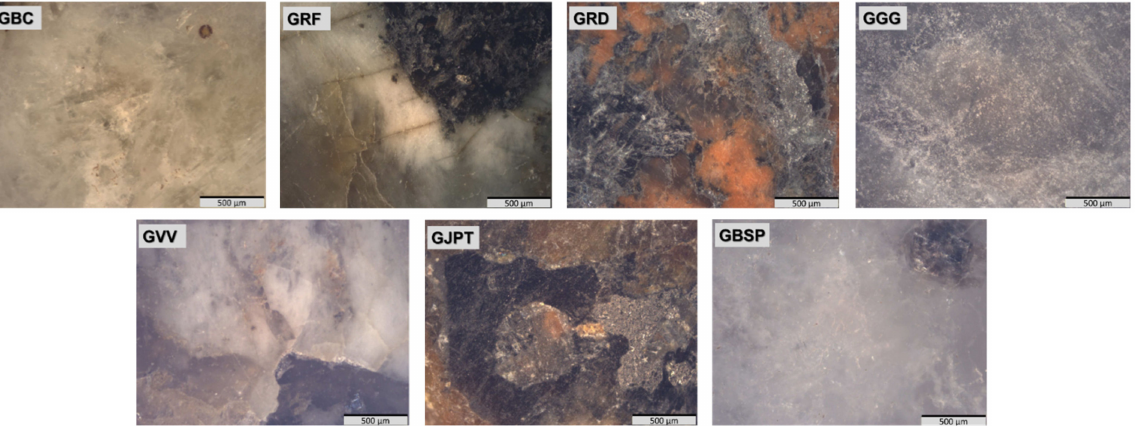
Figure 7. Optical stereomicrographs obtained from the surface of